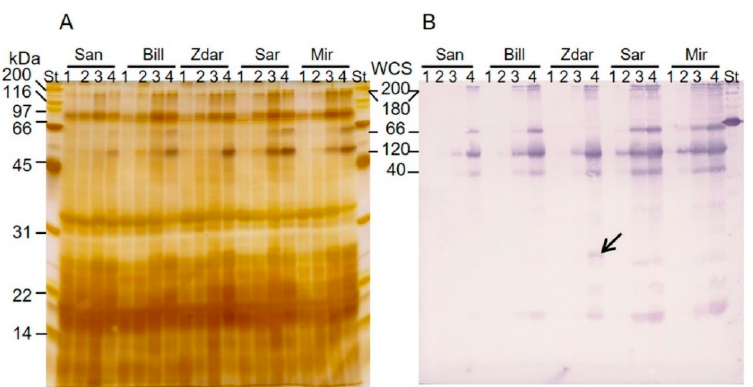
Figure 1. Accumulation of WCS120 proteins in the spring cultivar (Sandra) and the winter wheat cultivars cultivated at 25 °C (1), 17 °C (2), 9 °C (3) and 4 °C (4). ( A ) Silver-stained 1D SDS-PAGE gel. ( B ) Immunoblot with WCS120 proteins detected by anti-dehydrin primary antibody (against the K-segment). An arrow indicates a band visible only in Zdar (MW about 26 kDa). Mir-cultivar Mironovskaya 808, San-cultivar Sandra, Sar-cultivar Šárka, St-SDS-PAGE Molecular Weight Stand- ards, broad range (Bio-Rad, Hercules, CA, USA).